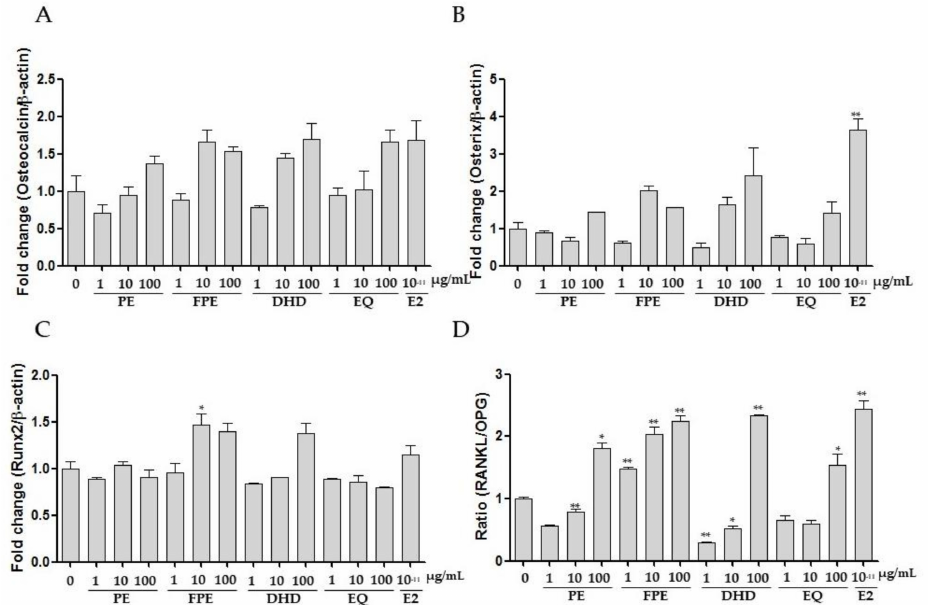
Figure 4. Expression of mRNA of osteogenic differentiation mediators, ( A ) osteocalcin/ β -actin; ( B ) osterix; ( C ) Runx2; ( D ) RANKL/OPG, in MG 63 cells measured by real-time RT-PCR. The expression of β -actin was used as a loading control for RT-PCR. * p < 0.05 compared to normal controls and ** p < 0.01 compared to control. The results are expressed as a mean ± SEM ( n =